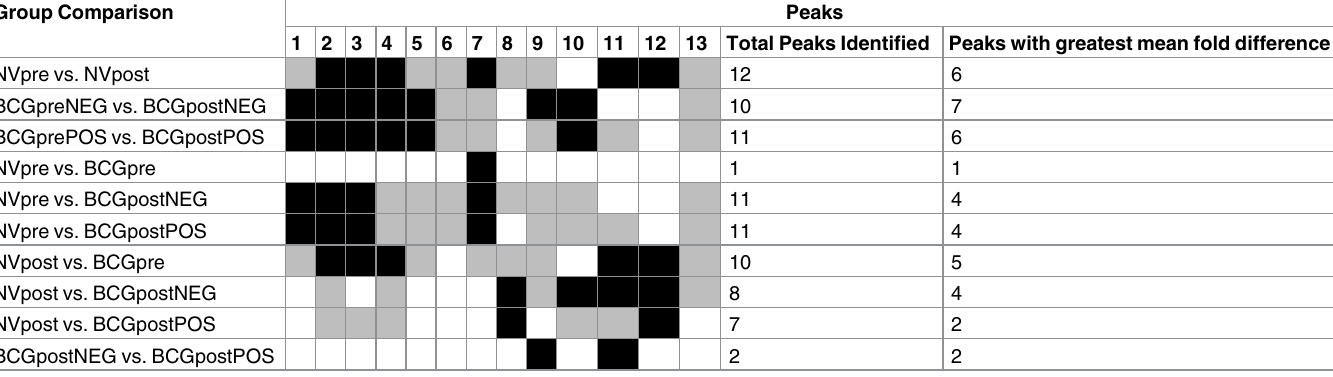
Table 5. VOC suites allowing discrimination between sample groups.